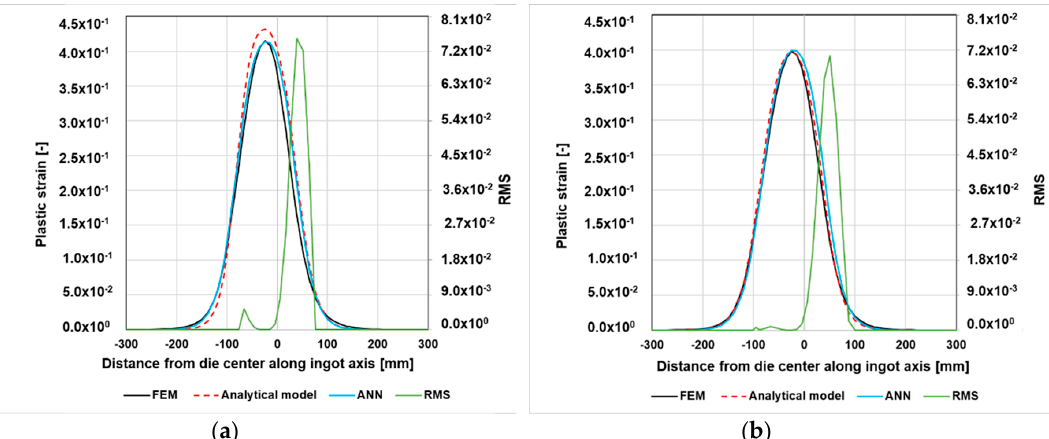
Figure 10. Total equivalent plastic strain as a function of length for Sb 0 = 150 mm, reduction of 25%, first stroke at ( a ) 800 °C, ( b ) 1200 °C.